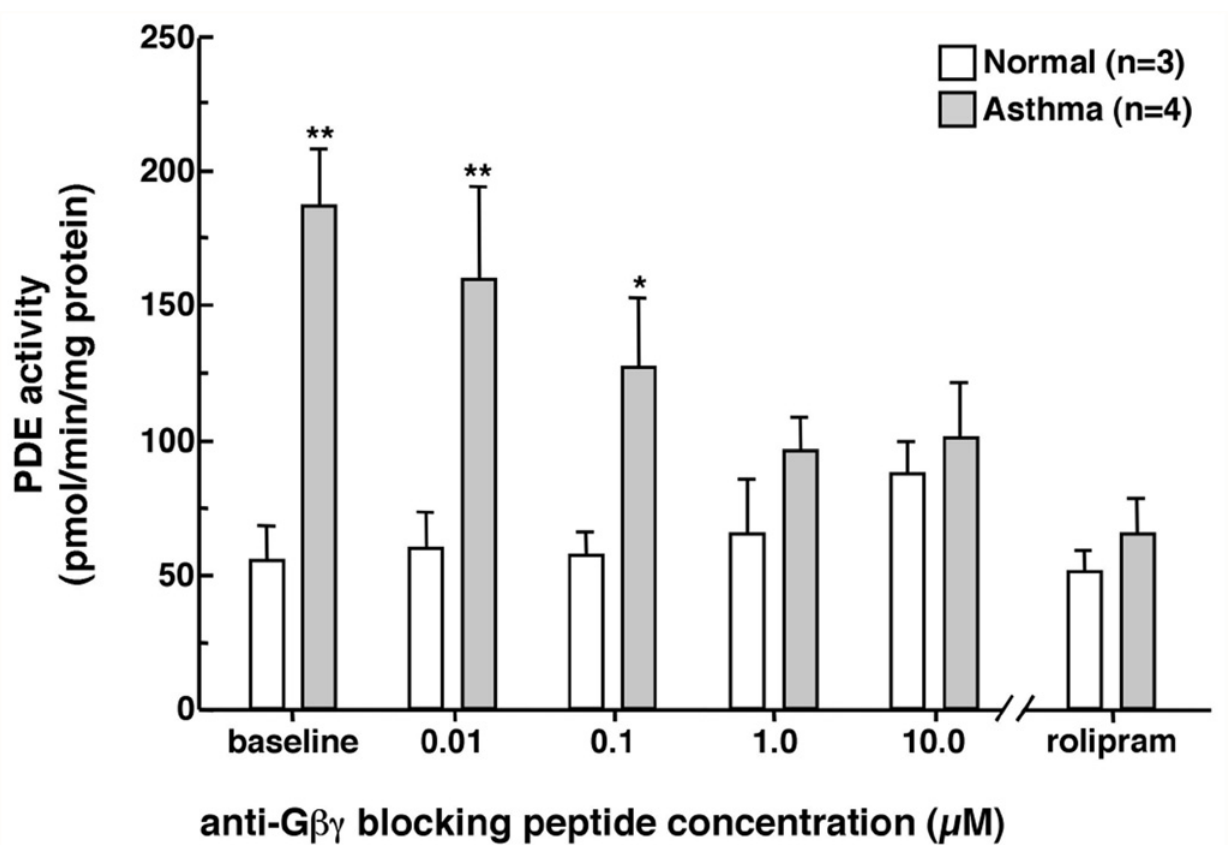
Fig 2. Dose-dependent effects of anti-G βγ blocking peptide on PDE activity in normal vs. asthmatic HASM cells. Relative to normal cells, basal PDE activity is significantly increased in asthmatic HASM cells. Unlike in normal cells wherein administration of anti-G βγ blocking peptide has no effect, asthmatic HASM cells treated with increasing doses of anti-G βγ blocking peptide (each dose treatment for 6 hr) exhibit significant dose-dependent suppression of PDE activity. Note, the maximal suppressive effect attained using 1 μ M is similar to that detected in asthmaic HASM cells treated with the PDE4 inhibitor, rolipram. Data are mean ± SE values. Comparisons of asthmatic HASM cells relative to basal normal levels are made using two-tailed Student t-test. * p < 0.05; ** p <